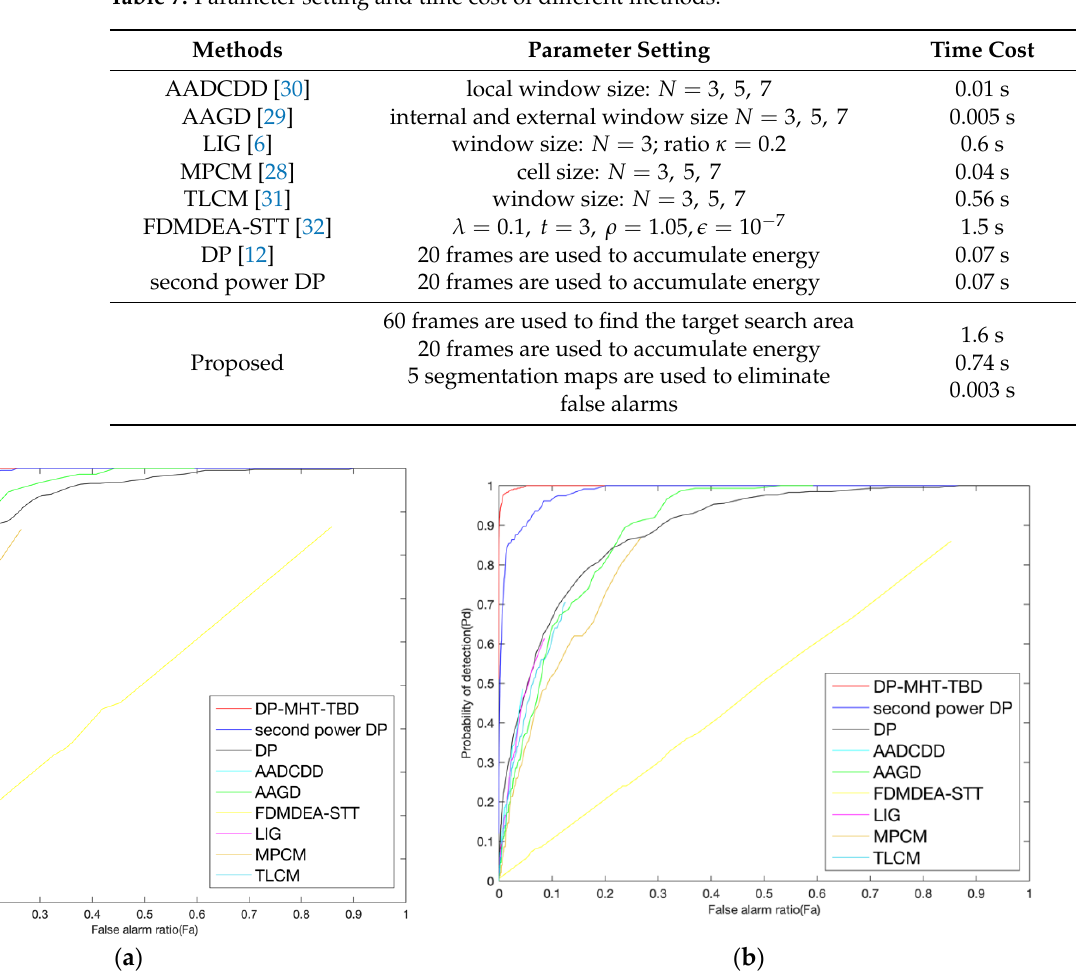
Figure 10. ROC curves of different methods under different data. ( a ) SCR is 1.5; ( b ) SCR is 1.4.